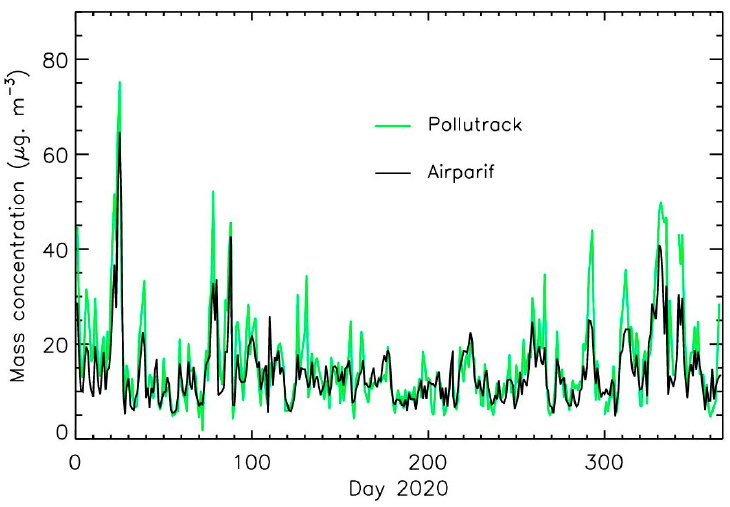
Figure 6. Comparison between the Pollutrack and Airparif daily averaged PM2.5 measurements.